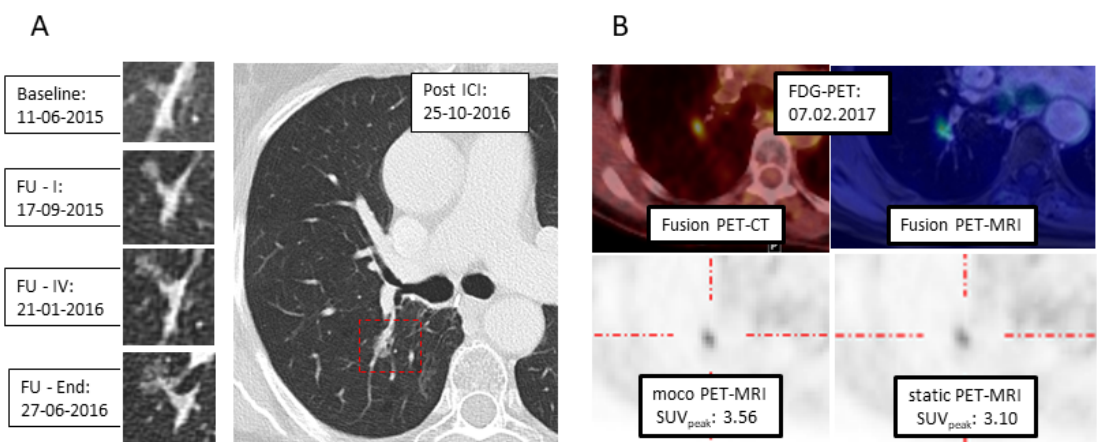
Figure 2. Example of respiratory motion correction in PET-MRI. ( A ) CT: Development of a semi-solid formation post- immunotherapy at the right hilum. ( B ) 18 F-FDG-PET with PET/CT (upper left) und PET-MRI (upper right): With MRI-based motion correction (moco), a higher SUV peak is calculated (lower left), compared to static reconstruction (lower right).